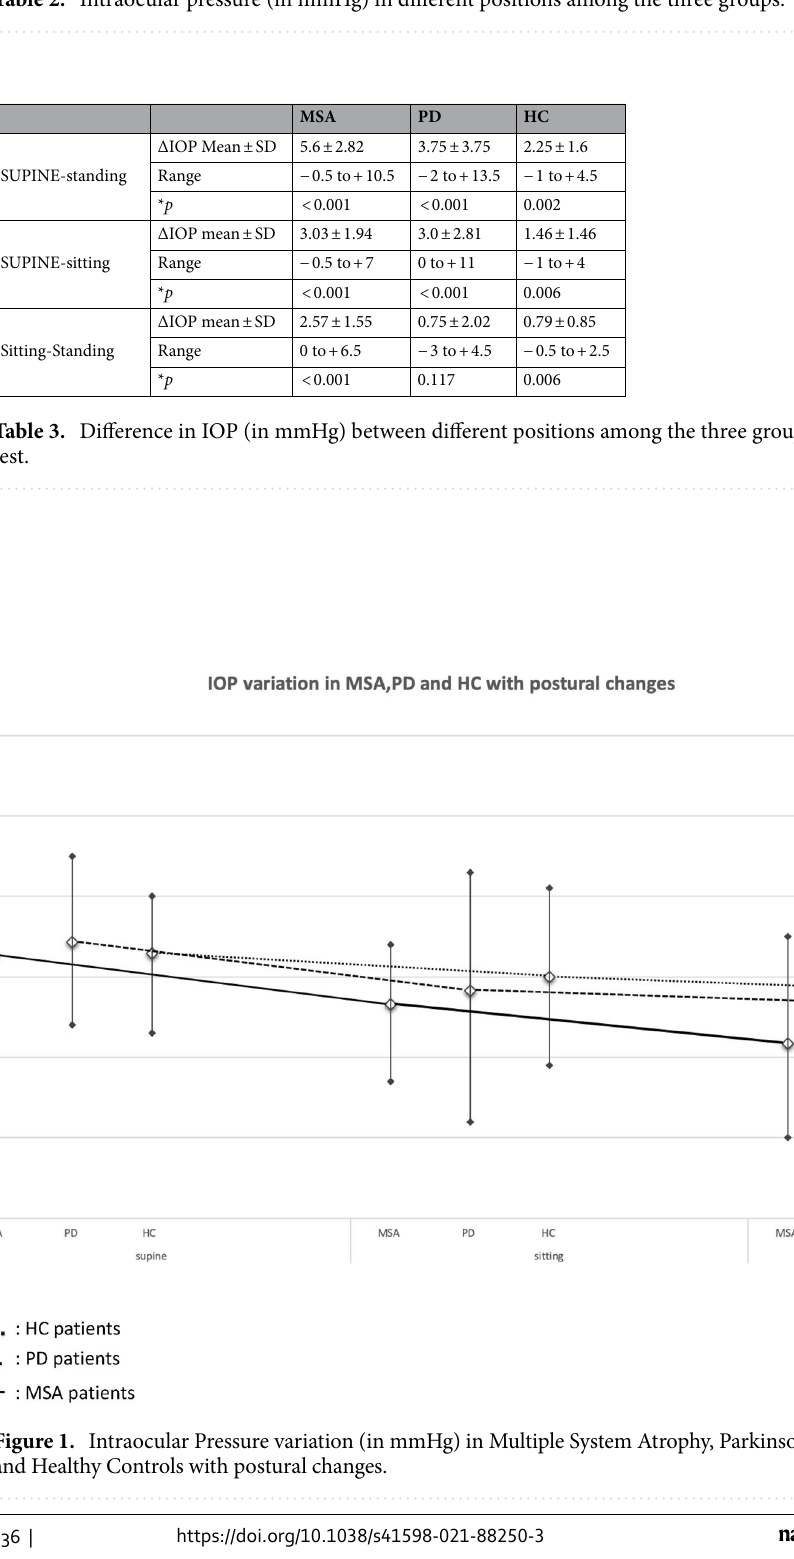
Table 2. Intraocular pressure (in mmHg) in different positions among the three groups.